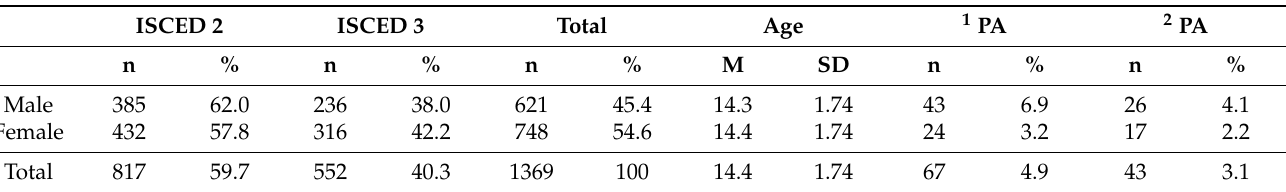
Table 1. Sample description stratified by